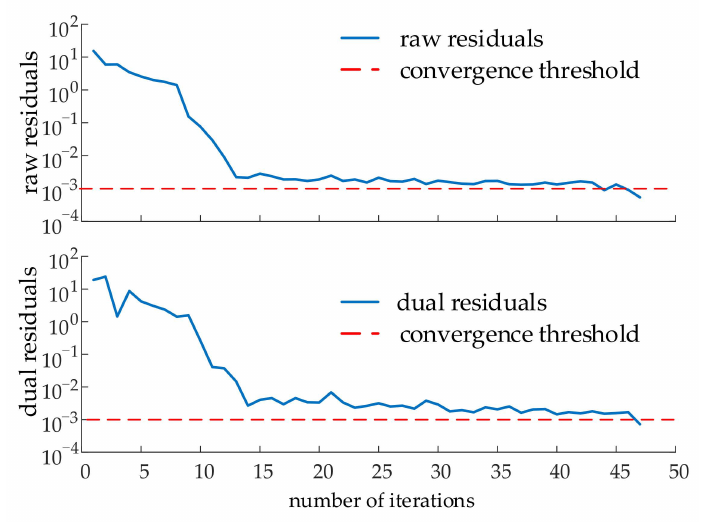
Figure 6. Original residual and dual residual convergence curves.